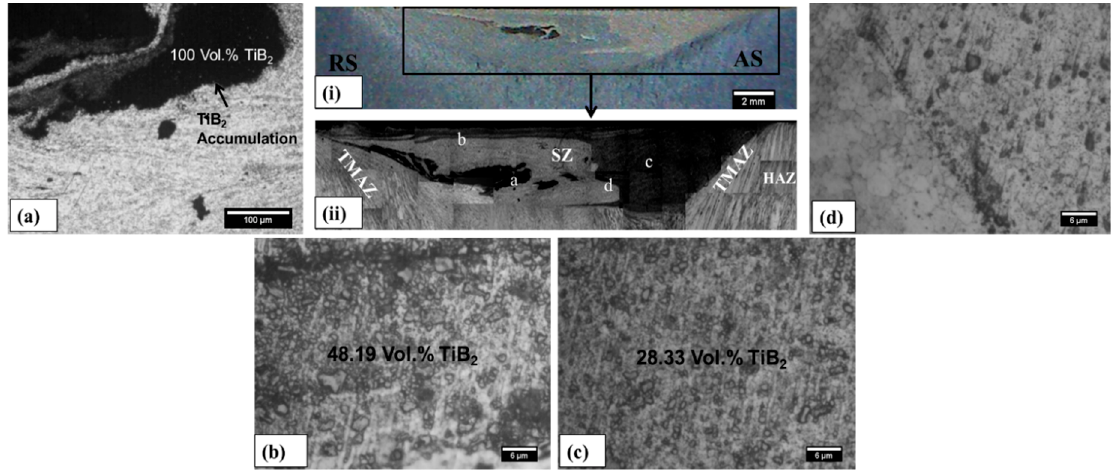
Figure 7. ( i ) Macro-image of cross-section of Sample 1. ( ii ) Microstructure of cross-section of the rectangle in macro-image showing: ( a ) agglomerated region; ( b ) mixed region; ( c ) dispersed region; and ( d ) composite and BM interface.